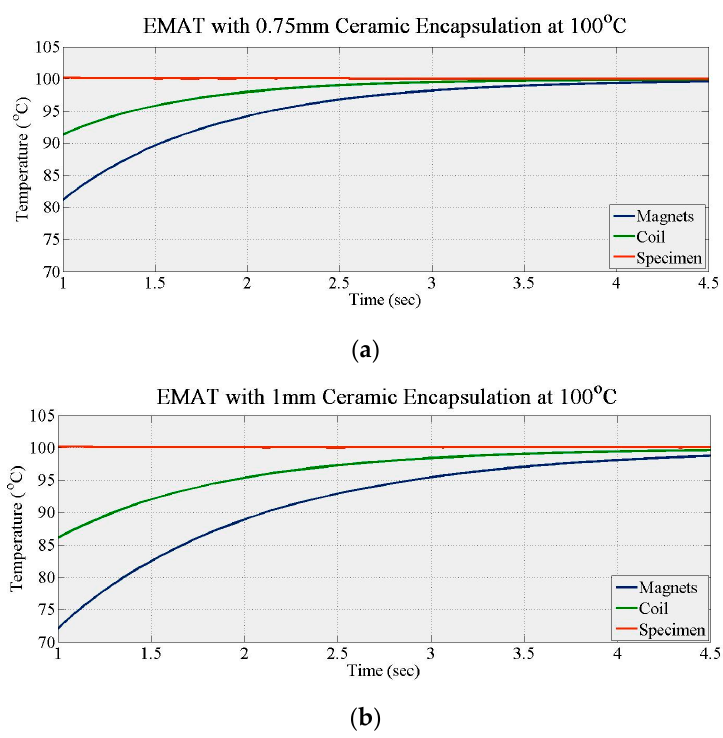
Figure 2. Temperature gradient of alumina encapsulated coil ( a ) 0.75 mm alumina thickness; ( b ) 1 mm alumina thickness.